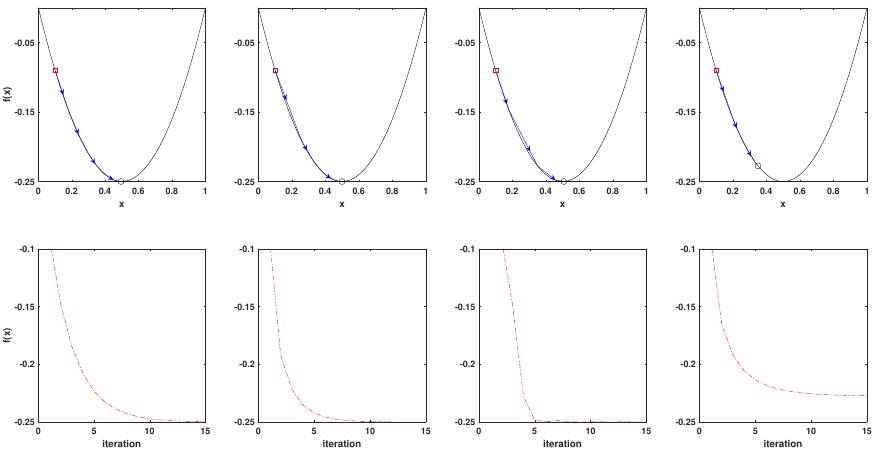
Figure 3. Illustration of minimizing function f ( x )= x 2 − x with different gradient descent methods, which include ( first column ) the first order gradient, ( second column ) the fractional order gradient based on the approximate chain rule (25), ( third column ) the fractional order gradient based on the approximate expansion (26), and ( last column ) the accurate fractional order